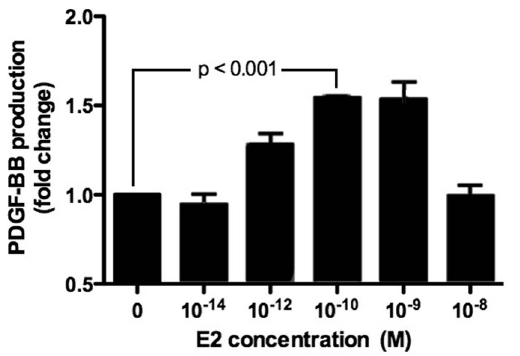
Figure 5. Dose-dependent changes in PDGF-BB production by brain endothelial cells in response to E2 treatment. Brain endothelial cells bEnd.3 were treated with indicated E2 concentrations for 24 h and analyzed using PDGF-BB ELISA.